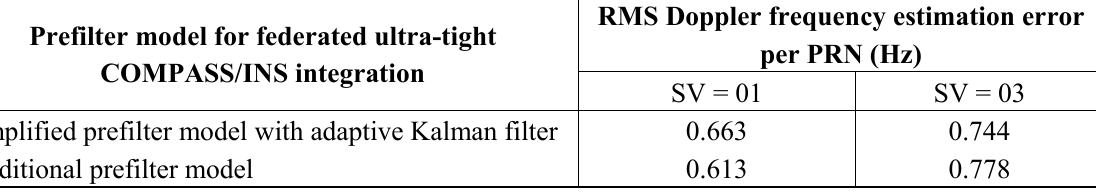
Table 5. RMS Doppler frequency errors of tracked SVs with different prefilter models.